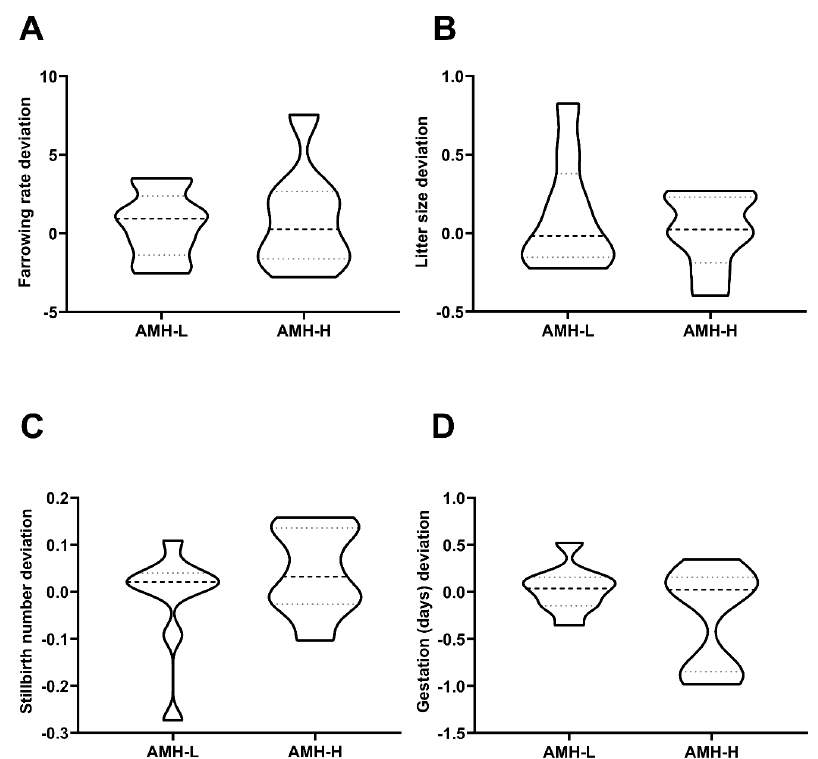
Figure 5. Association between the concentration of the anti-Müllerian hormone in seminal plasma (SP-AMH) and in vivo fertility parameters of boars in terms of direct boar e ff ect. A total of 17 Artificial Insemination (AI)-boars (n = 3 ejaculates per boar) were classified as having low- (AMH-L; ranging from to 494.10 to 774.47 ng / mL, n = 9) or high- (AMH-H; ranging from 770.53 to 1096.72 ng / mL, n = 19) SP-AMH concentration in their ejaculates (mean of three ejaculates). Violin plots represent deviations and distribution of ( A ) farrowing rate deviation, ( B ) litter size deviation, ( C ) stillbirths number deviation, and ( D ) the gestation (days) deviation of these AI-boars. Dashed line represents the median and dotted lines the 25 and 75% quartiles. No significant di ff erences were found between SP-AMH groups in any in vivo fertility